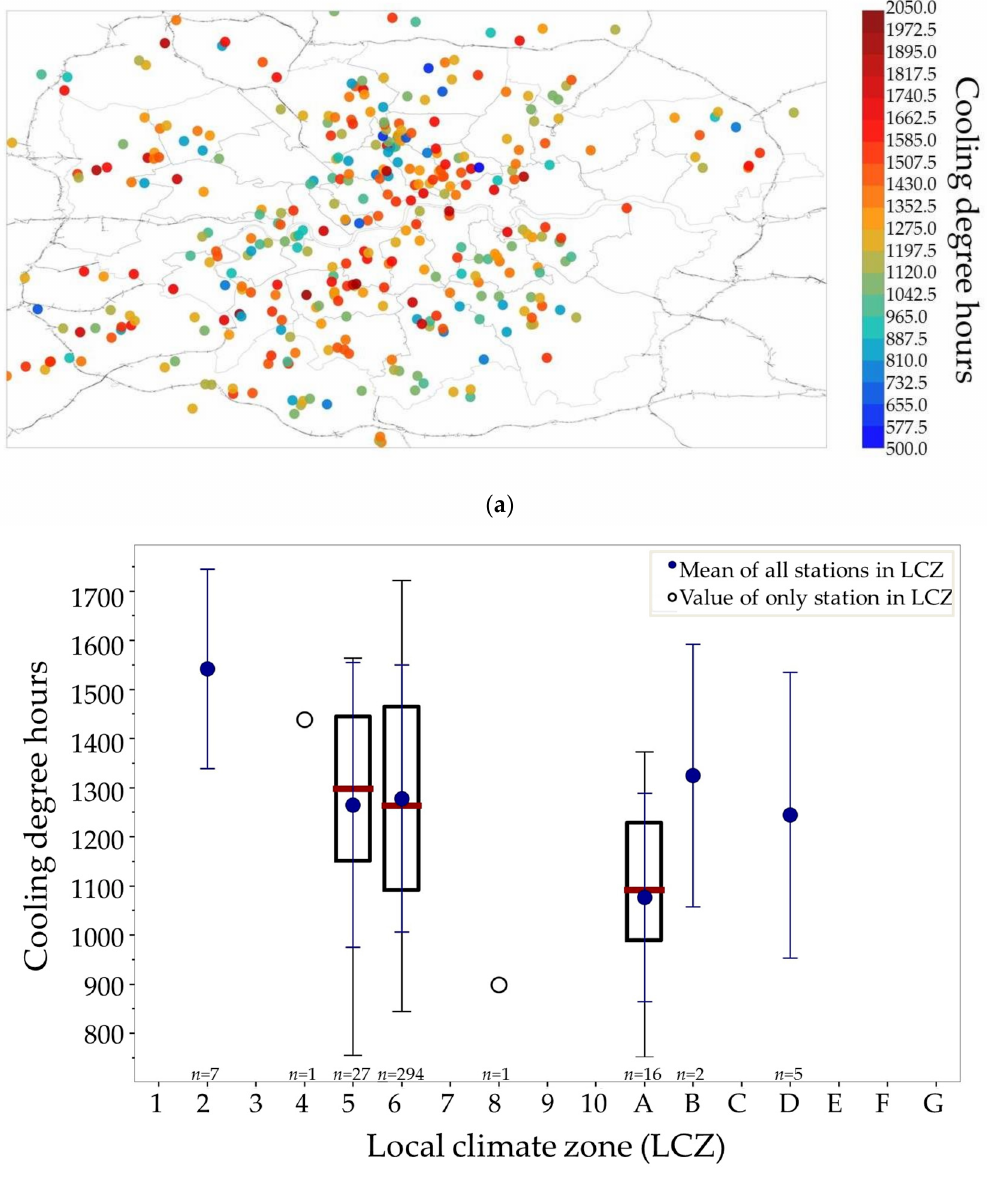
Figure 9. Building cooling demand in London in July 2018: ( a ) the spatial distribution of cooling degree hours. Red colours indicate greater cooling demand than blue colours. ( b ) The mean cooling degree hours of each LCZ. Filled blue dots represent LCZs with more than one station inside; unfilled dots represent LCZs with only one station inside. Errors on the means are one standard deviation. Boxes are plotted for LCZs with more than ten stations within them. The meaning of the bounds and whiskers of the boxes are explained in Figure 5.